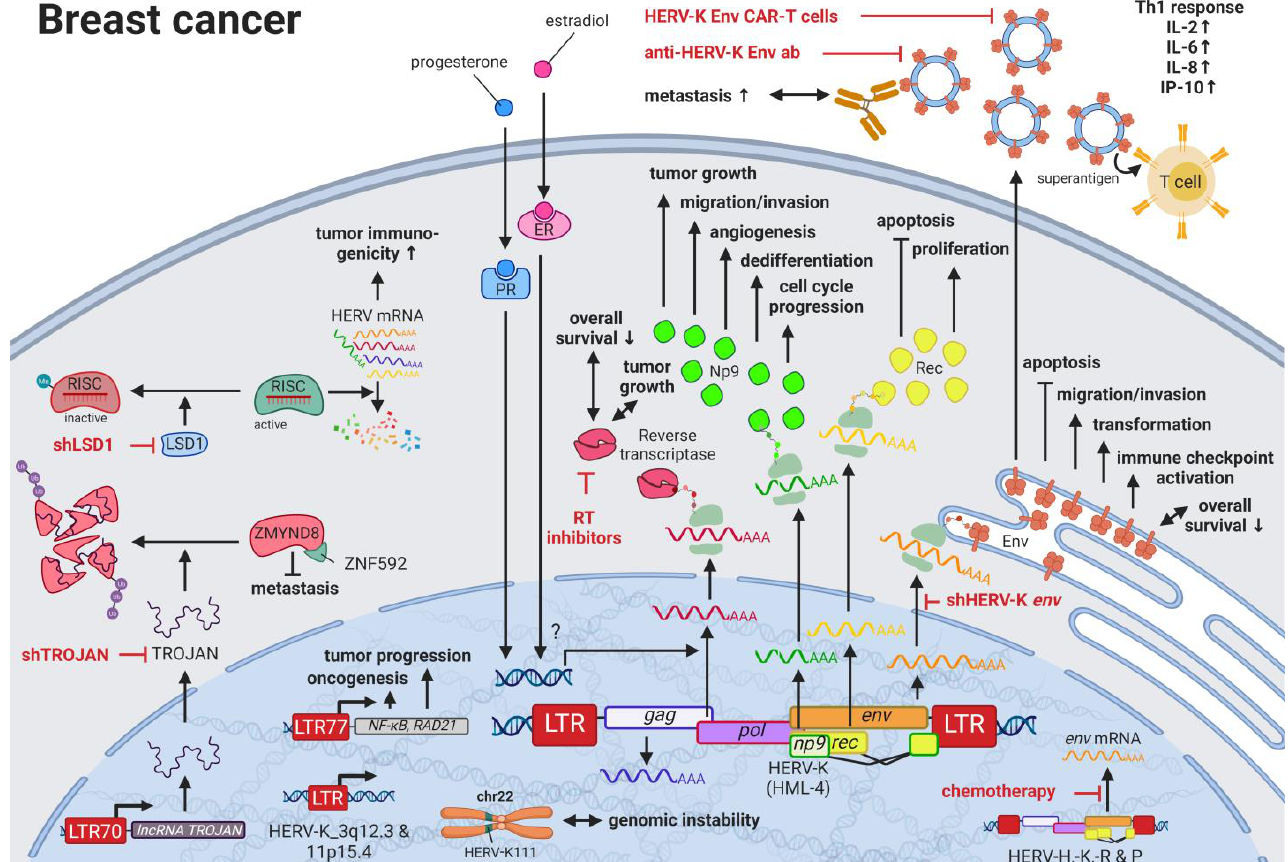
Figure 1. The role of HERVs in breast cancer. Evaluated treatments are marked in red. Abbreviations: Th1 = T helper cell 1, ER = estradiol receptor, PR = progesterone receptor, LTR = long terminal repeat, gag = group antigen (capsid), pol = polymerase, RT = reverse transcriptase, env = envelope. If not otherwise stated HERV-K =